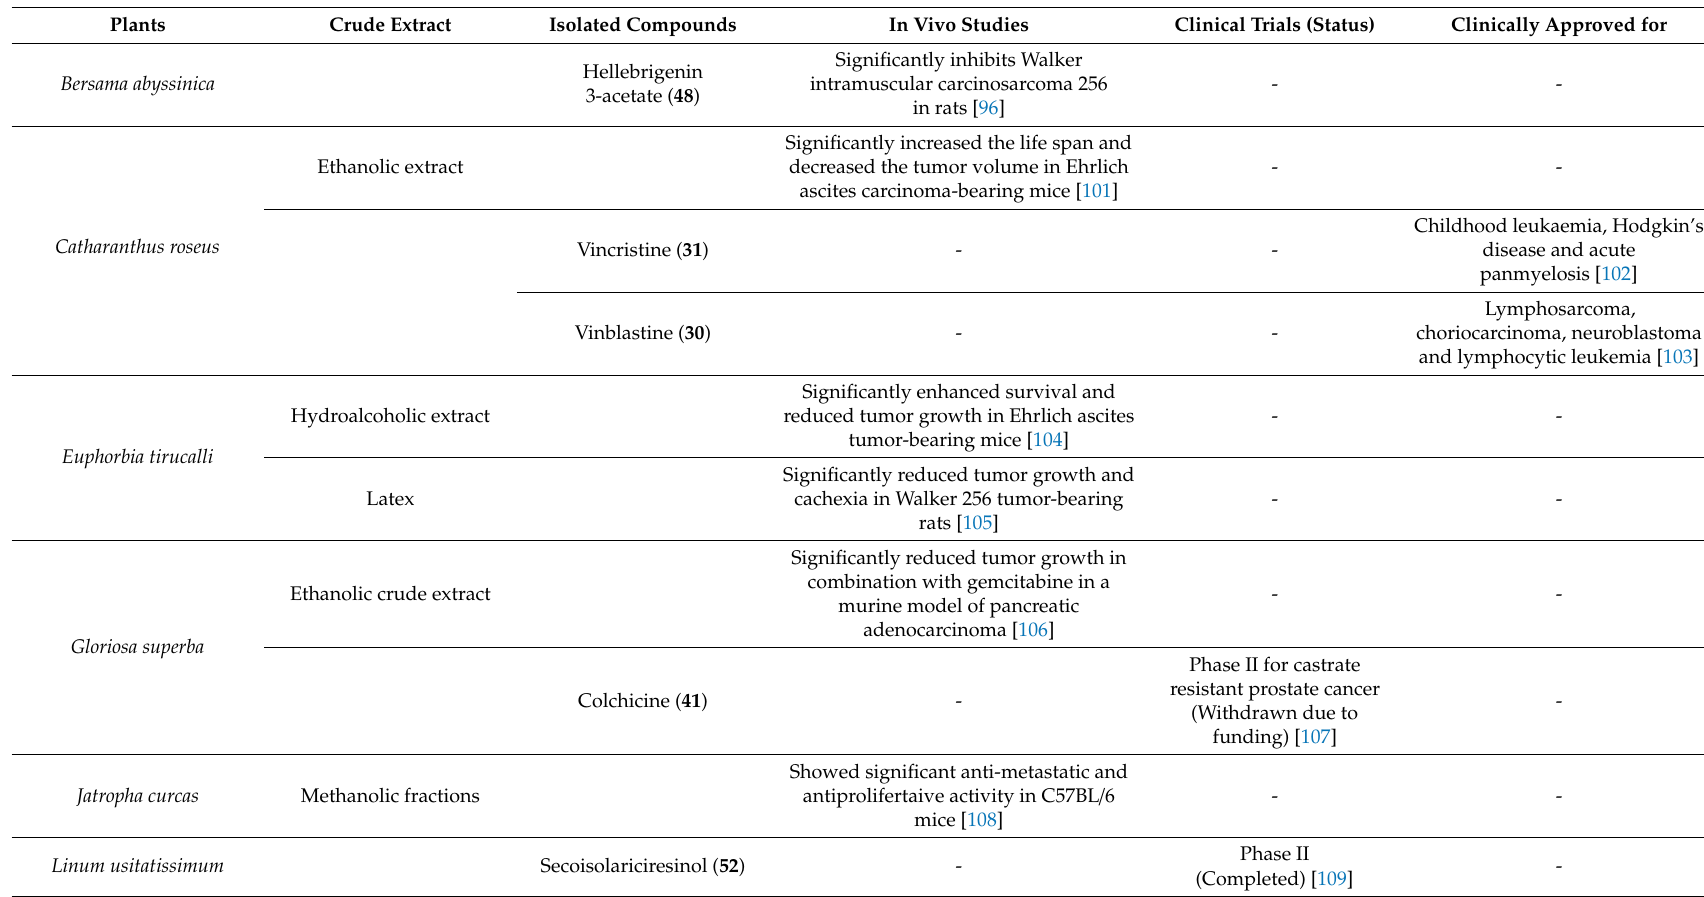
Table 6. Animal e ffi cacy studies, clinical trials, and / or clinically approved agents among Ethiopian anticancer plants /